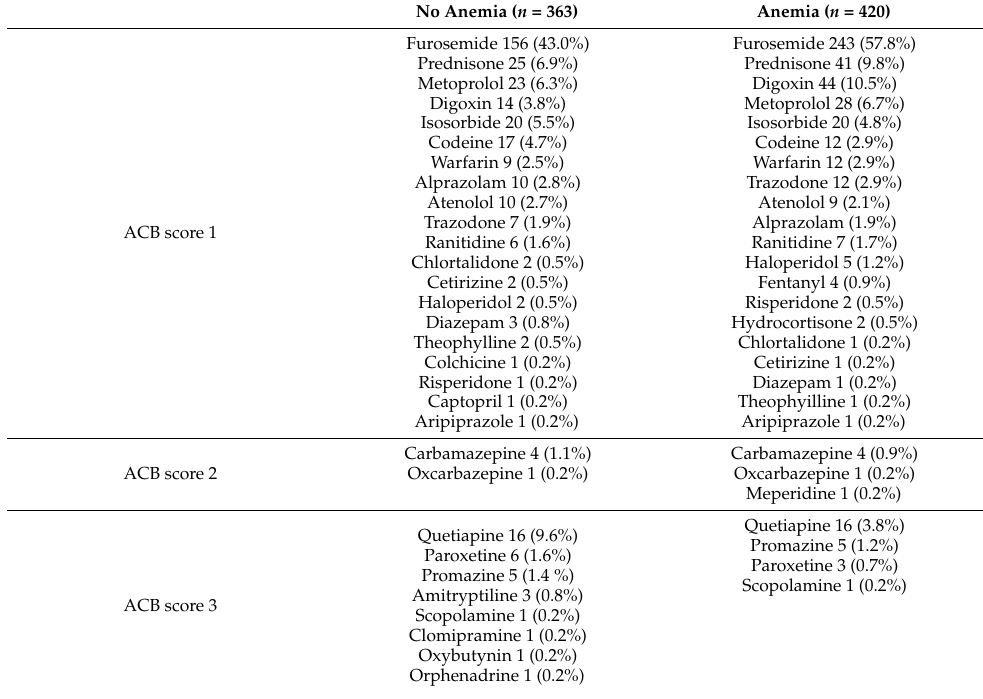
Table 2. Anticholinergic Cognitive Burden (ACB) listed medications prescribed at discharge in the study population according to diagnosis of